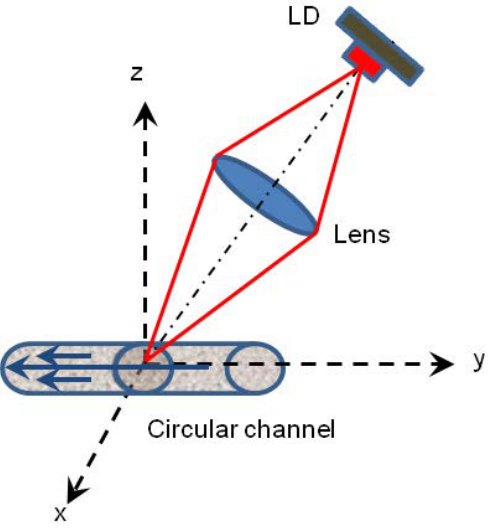
Figure 9. Experimental configuration for fluid flow profile